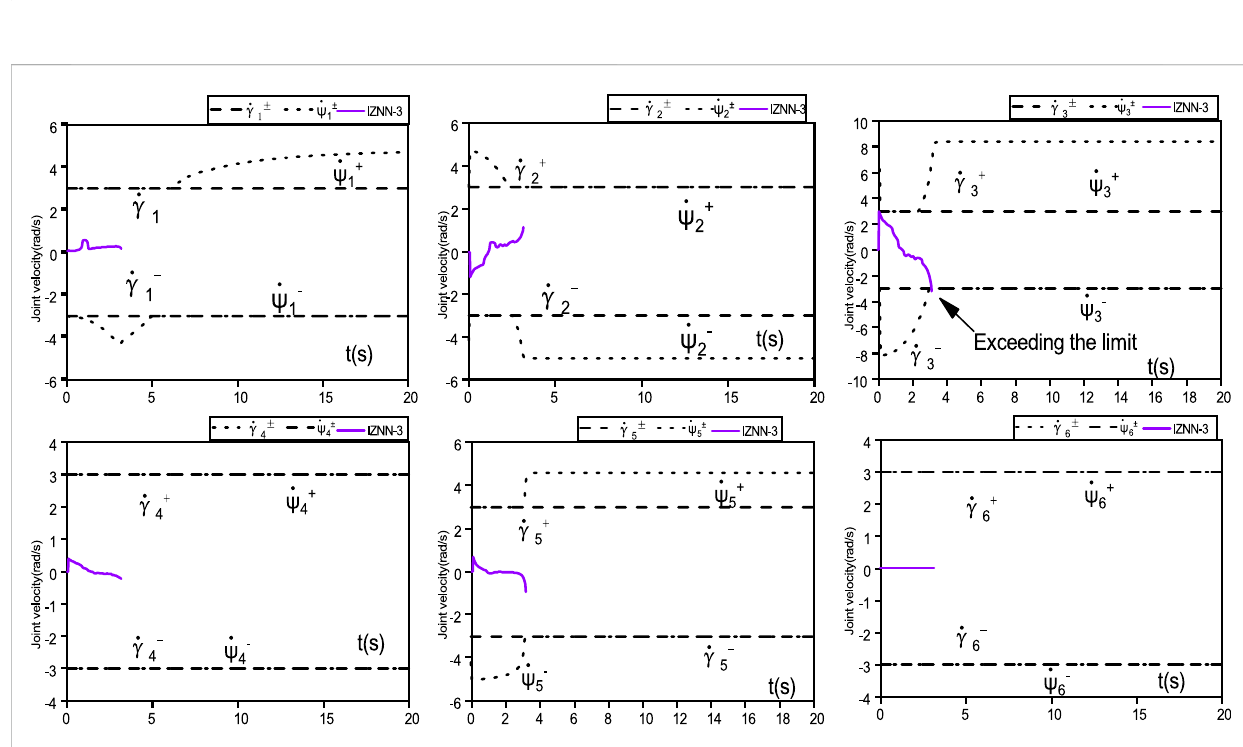
FIGURE 12 The IZNN-3 model-controlled wheeled robot fails trajectory tracking with Joint velocities exceed